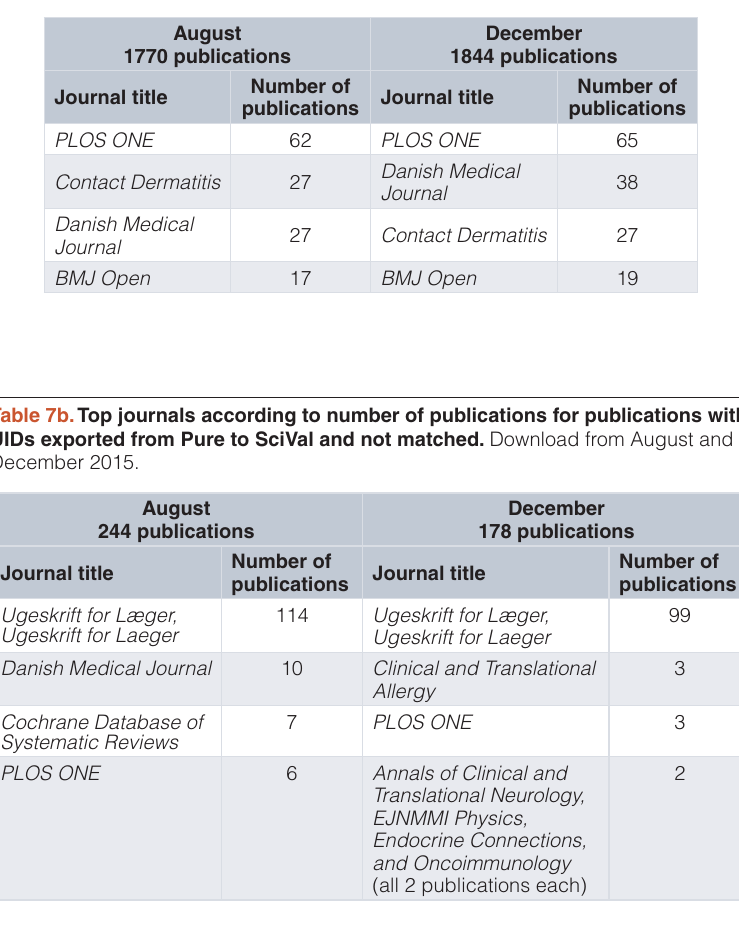
Table 7a. Top journals according to number of publications, for publications with UIDs exported from Pure to SciVal and matched. Download from August and December